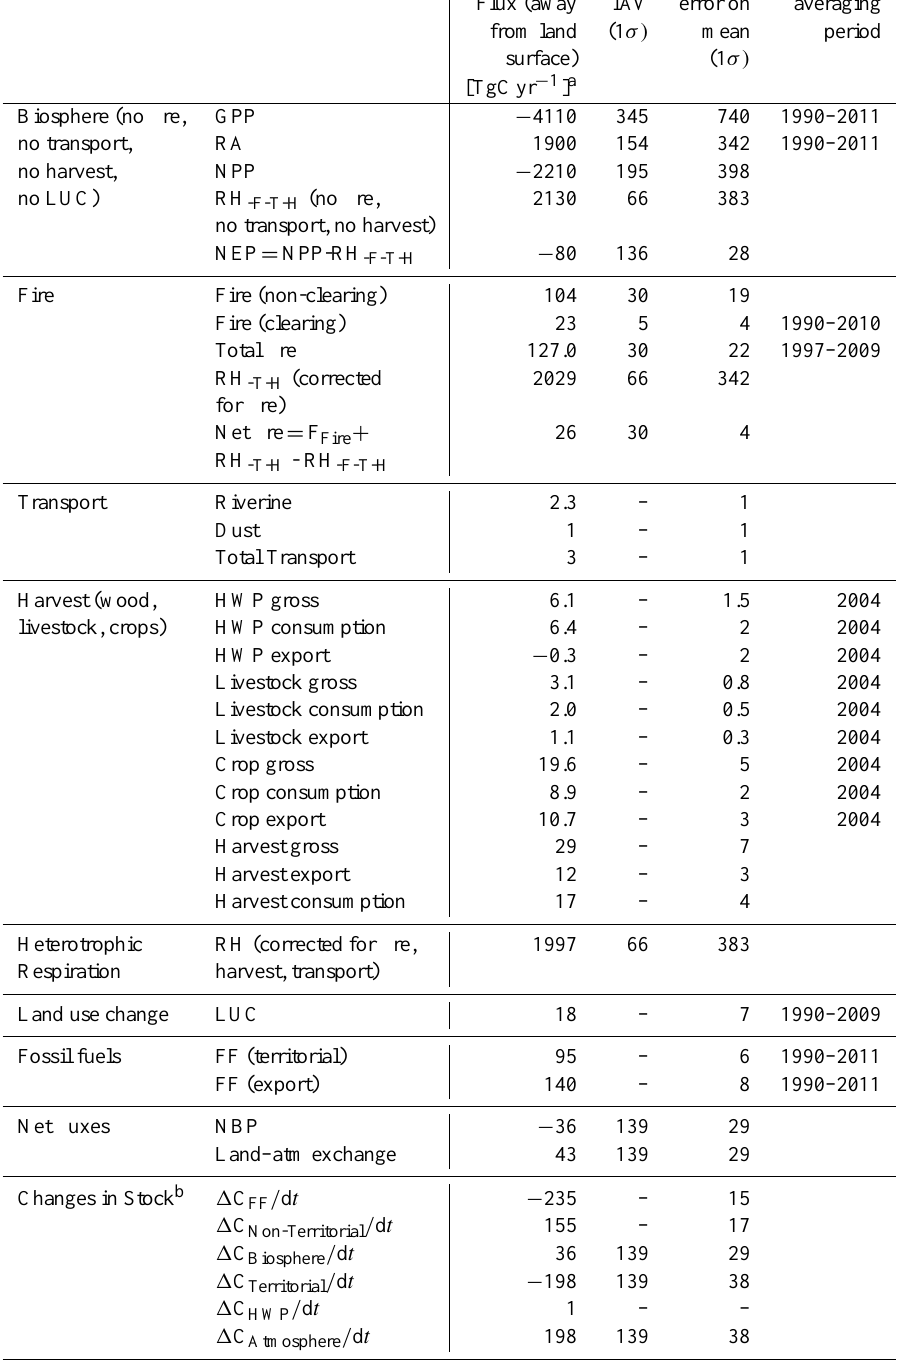
Table 1. Components of the Australian carbon